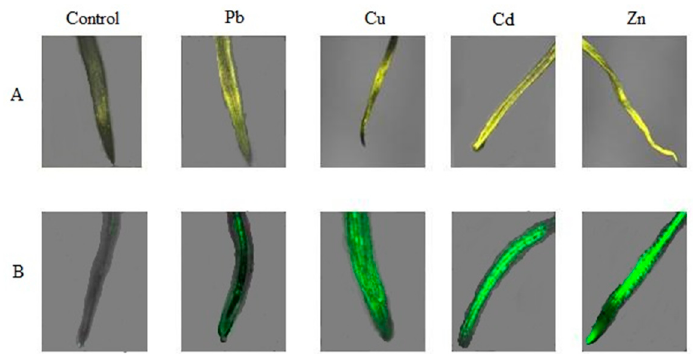
Figure 5. Trace metals-induced O 2 −· and H 2 O 2 production in B. juncea var. Malopolska roots. Fluorescent images of B. juncea roots grown in Hoagland’s medium in the presence of 50 µ mol of Pb(NO 3 ) 2 , CuSO 4 , CdCl 2 , and ZnSO 4 for 24 h and control roots of plants stained with DHE for 12 h ( A ) and DCFH-DA for 4 h ( B ). The bar indicates 1 μ m.